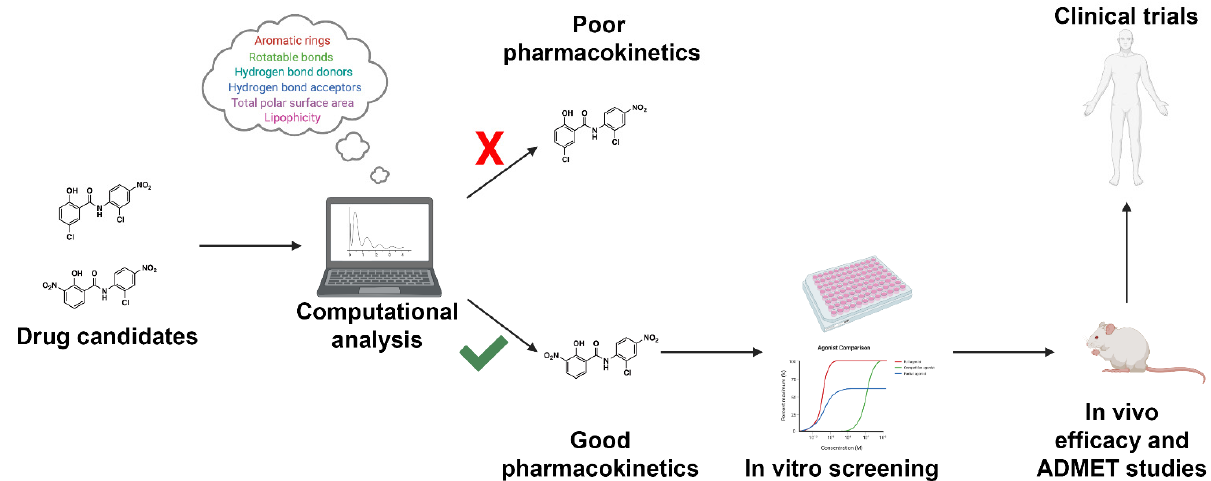
Figure 9. Workflow for incorporating ADMET predictions into early-stage drug design and development. Drug candidates can be readily screened using high-throughput computational approaches. Drugs with acceptable pharmacokinetic parameters as defined by the investigator will proceed to in vitro screening. Drugs with unacceptable pharmacokinetic properties will be triaged early in drug development. The following approach will result in a reduction in ADMET-related drug failures, reducing the cost of drug discovery efforts.